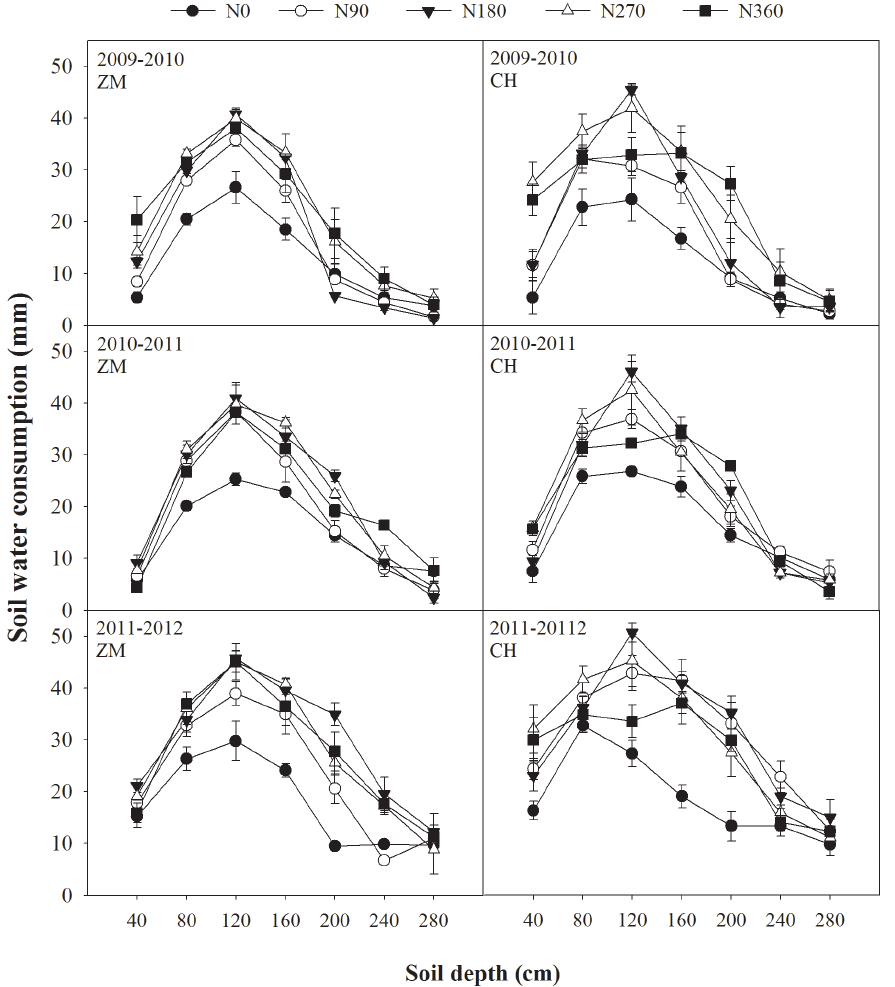
Figure 3. Wheat evapotranspiration (ET) (mm) of two cultivars in different soil layers and different nitrogen (N) treatments in three years. Water ET trends as soil depth increased with influence of N fertilizer for two cultivars in three years. Standard error bars are also shown.